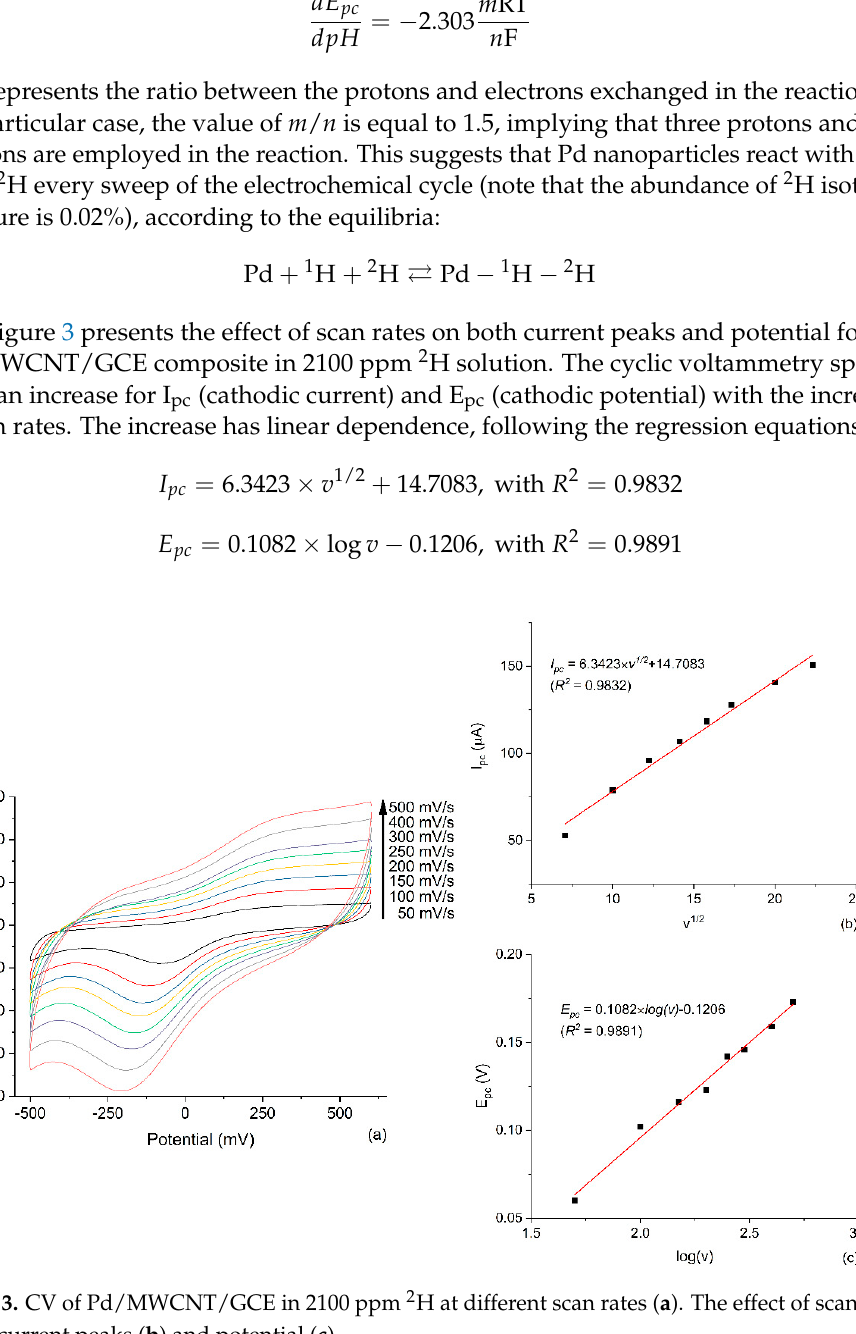
Figure 3. CV of Pd/MWCNT/GCE in 2100 ppm 2 H at different scan rates ( a ). The effect of scan rates on the current peaks ( b ) and potential ( c ).